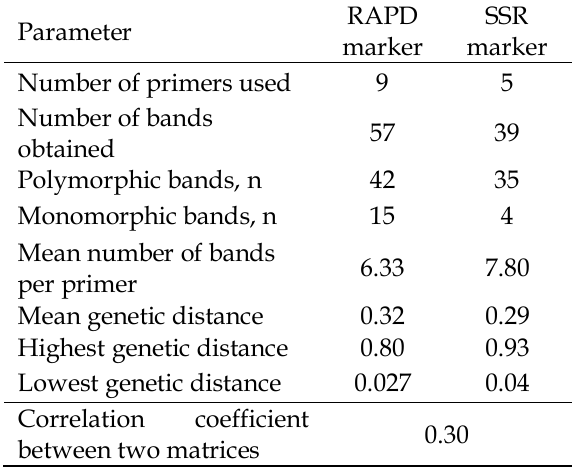
Figure 8 . Dendrogram showing 40 finger millet landraces based on Nei’s genetic distance calculated from 9 RAPD and 5 SSR markers profile using UPGMA methods with bootstrap of 1000 replications. Table 4. Comparison between the RAPD and